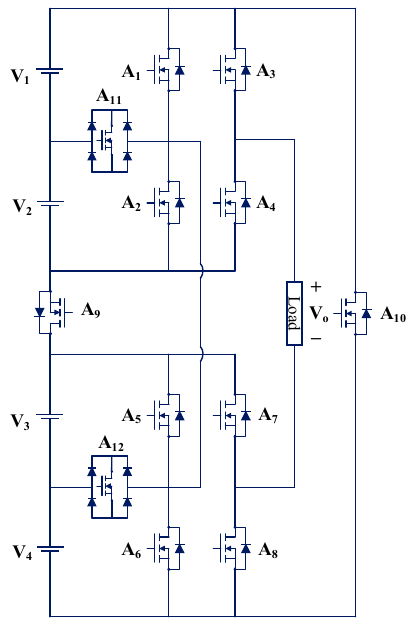
Figure 26. Single-phase FT MLI (TP29) [61].